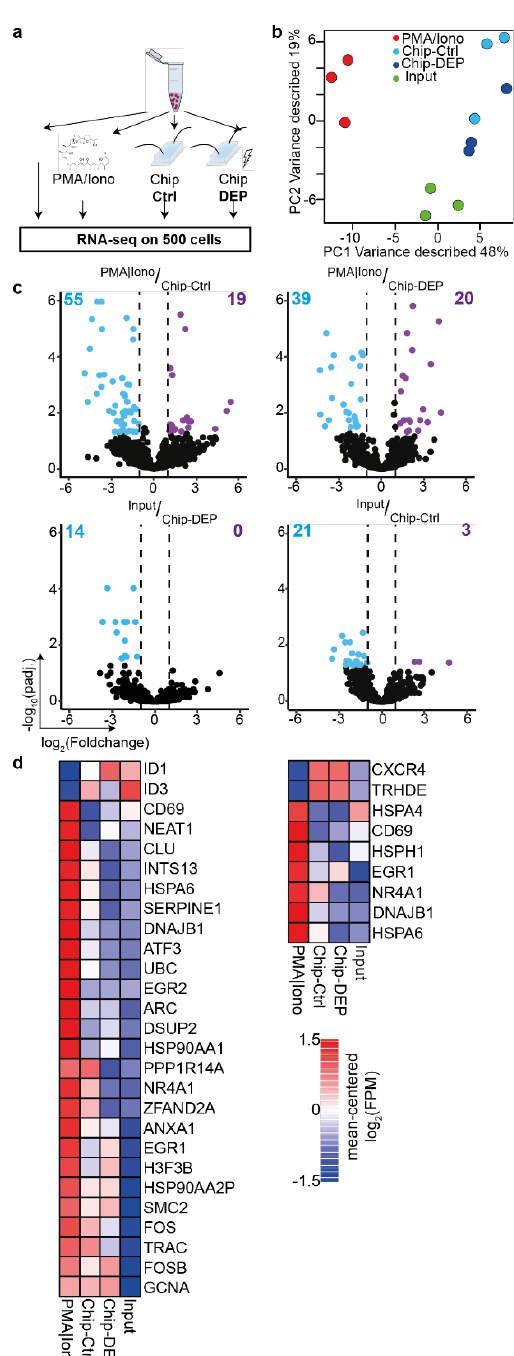
Figure 5. The electric field has minor molecular impact on Jurkat T-cells. ( a ) Jurkat cells were either injected into the microfluidics chip (Chip-Ctrl) or additionally subjected to the electric field used for accurate capture and retrieval of cells (Chip-DEP). Controls were either the input cells (Input) or cells activated for three hours under Phorbol-12-myristate 13-acetate and Ionomycin activation (PMA/Iono). Cells from all conditions were cultured for three hours to permit transcriptional changes to take place subsequent to treatment. ( b ) Principal component analysis on all differentially expressed genes (number of DEGs: 117). ( c ) Volcano plots of mean RNA-seq FPM (Fragment Per Million) comparing indicated samples. Number of DEGs is indicated. ( d ) Heatmaps represent expression of selected DEGs. Left: DEGs between PMA/Iono-stimulated and Input cells. Right: DEGs common on comparing Chip-Ctrl and Chip-DEP to PMA/Iono-stimulated cells. Experiments were performed in three independent biological replicates. DEG, differentially expressed gene (absolute(log2[foldchange] >= 1 and padj. <= 0.05).